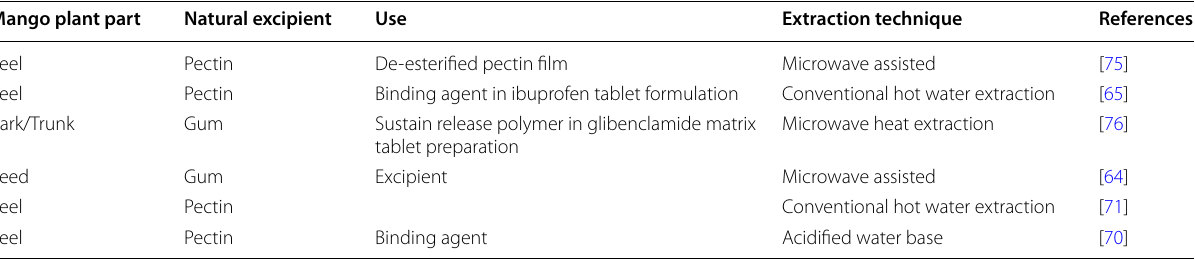
Table 3 Summary of excipients obtained from mango plant parts Mango plant part